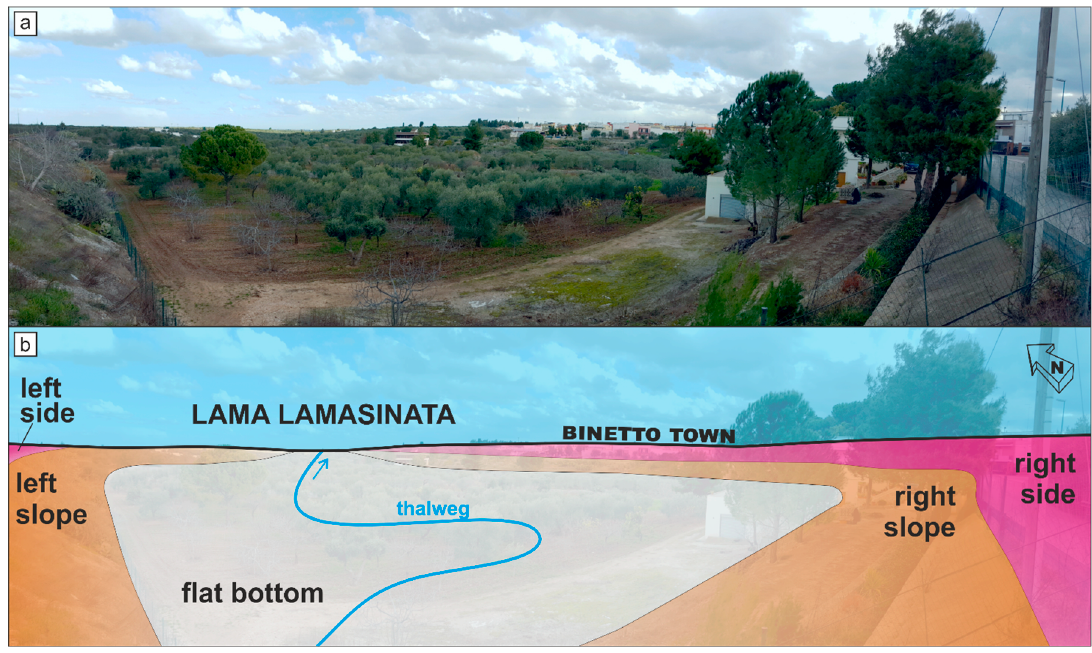
Figure 6. ( a ) Panning view of Lama Lamasinata from SW (16 ◦ 42 (cid:48) 12,084”E–41 ◦ 1 (cid:48) 28,973”N); the typical morphological features of an incised lama are visible; namely, a flat bottom, filled by alluvial deposits, gradually connected with surrounding slopes are well-recognizable. The thalweg is obliterated by agricultural activities set on alluvial deposits. ( b ) Schematic sketch of panel ( a ); the thalweg is purely representative.